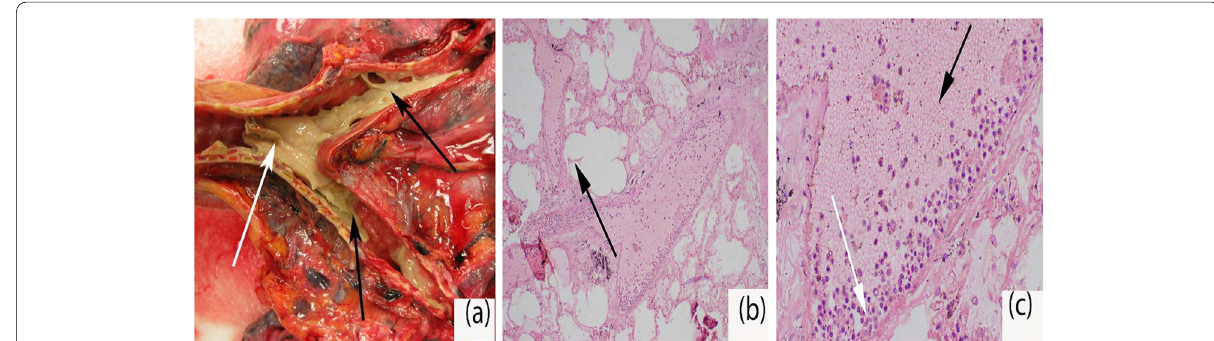
Fig. 1 Macroscopic appearance of respiratory passage showing gastric contents in trachea (white arrow) and the bronchial tree (black arrows) ( a ) and microphotograph of lungs H&E (10 0.25) ( b ) showing expanded alveoli with broken septa (black arrow) and (40 × bronchioles filled with eosinophilic materials (black arrow) and significant number of neutrophil infiltrations at the margin (white arrow)